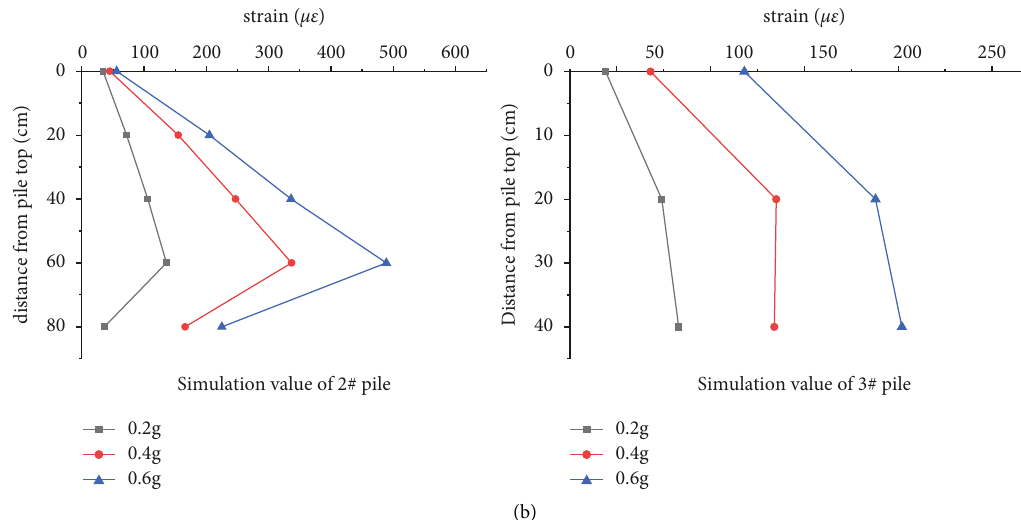
Figure 7: Test and simulation values of peak strain of 2 # pile and 3 # pile: (a) test value of peak strain of 2 # pile and 3 # pile and (b) simulation value of peak strain of 2 # pile and 3 #